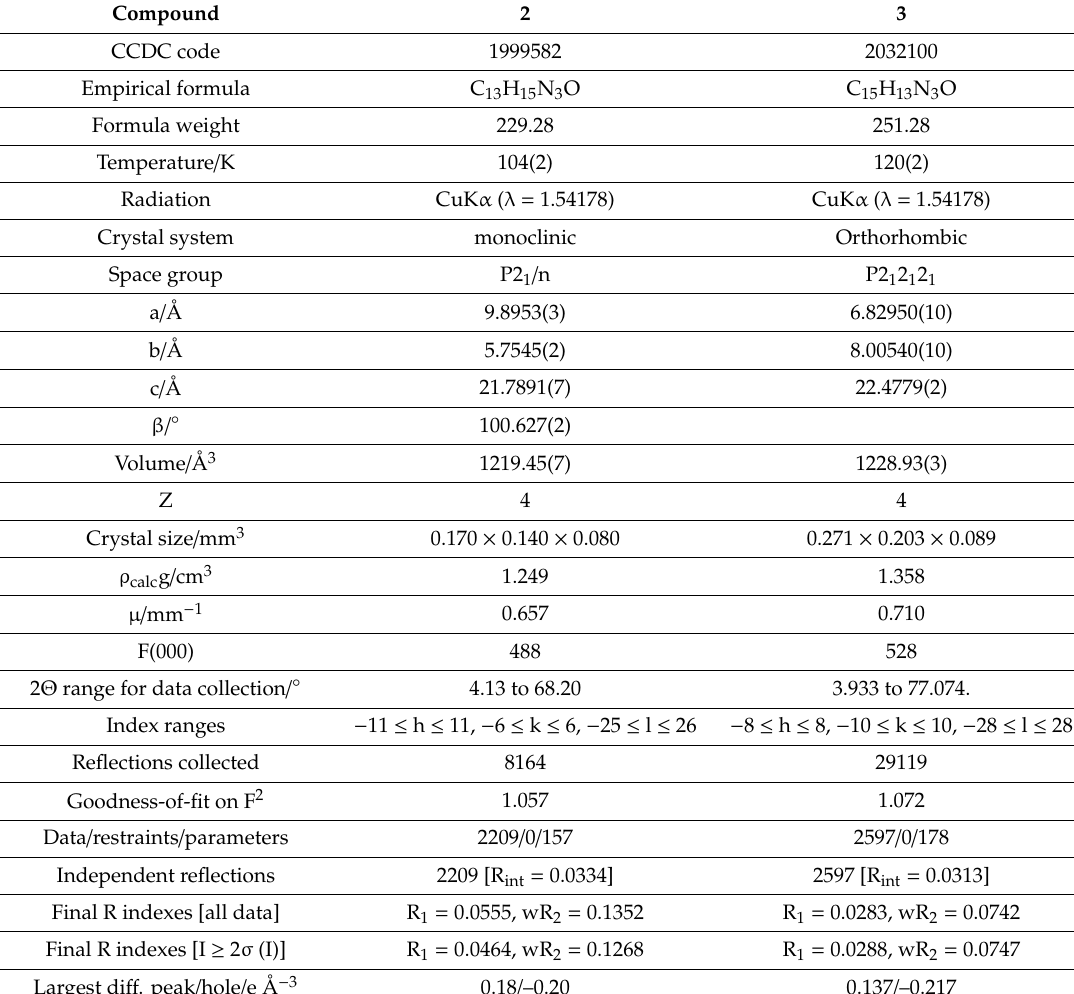
Table 1. Single crystal data and structure refinement